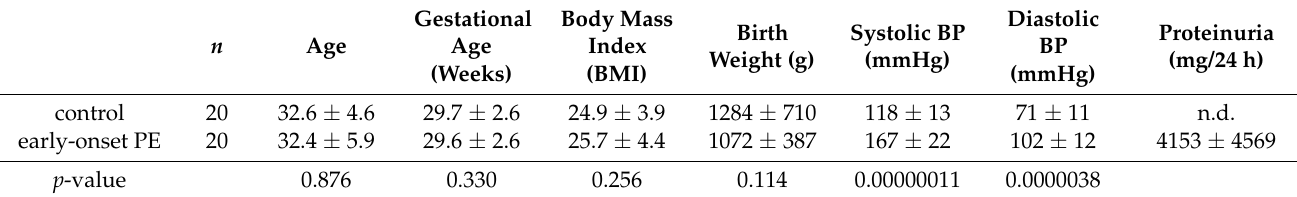
Table 2. Clinical information of patients with early-onset preeclampsia (ePE) and matched controls. Mean value ± standard deviation is shown. BP, blood pressure; n.d., not